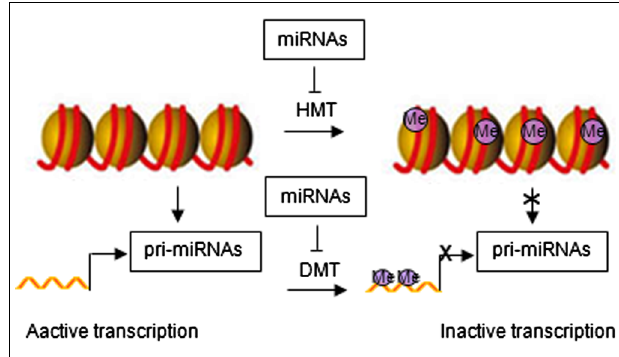
FIGURE 2 | Regulatory networks between epigenetic modification and miRNAs. HMT, histone methyltransferase; DMT, DNA methyltransferase; Me, methylation.